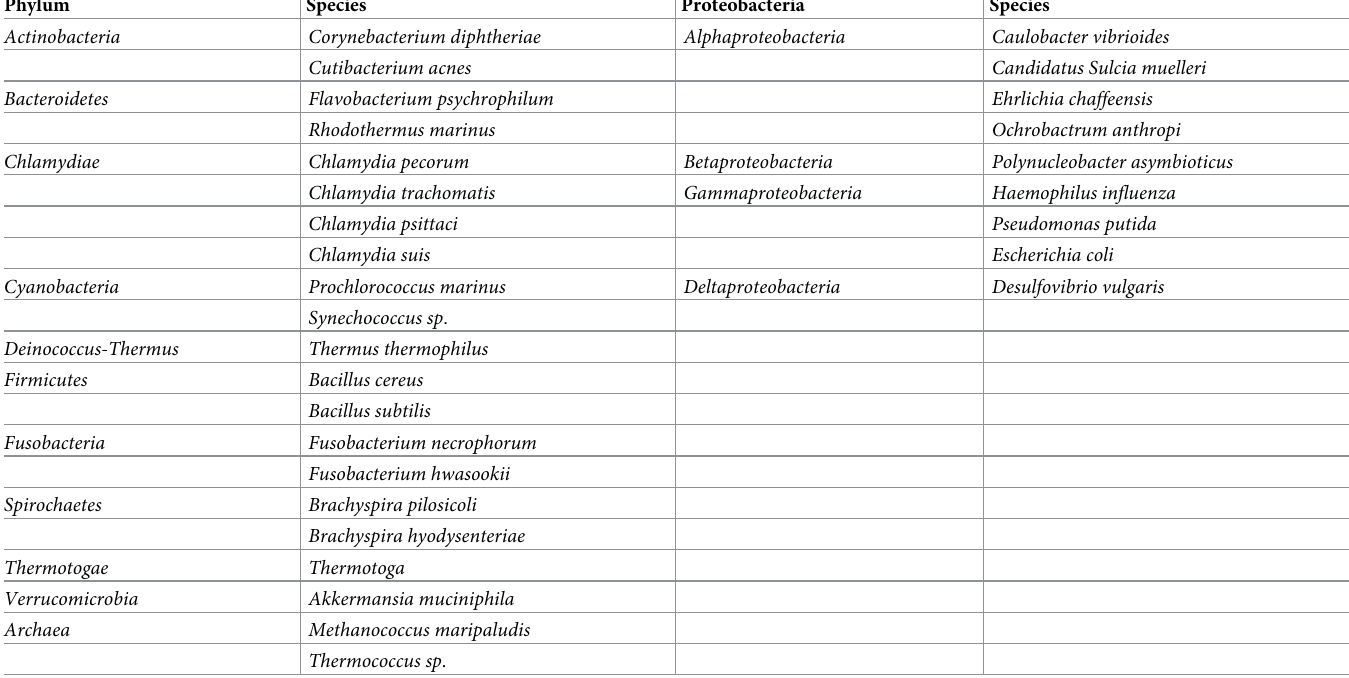
Table 1. Prokaryotic species used in this